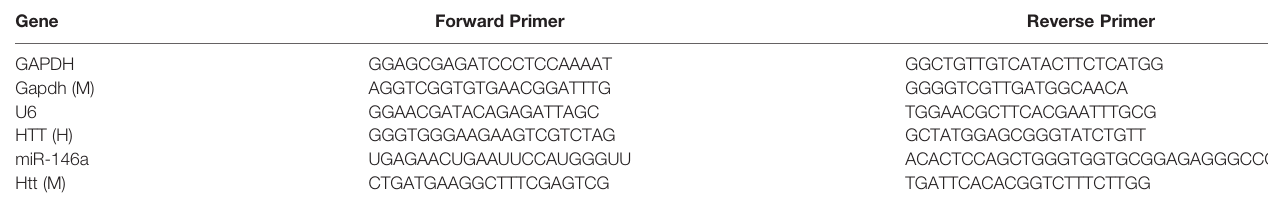
TABLE 2 | Primers used in this